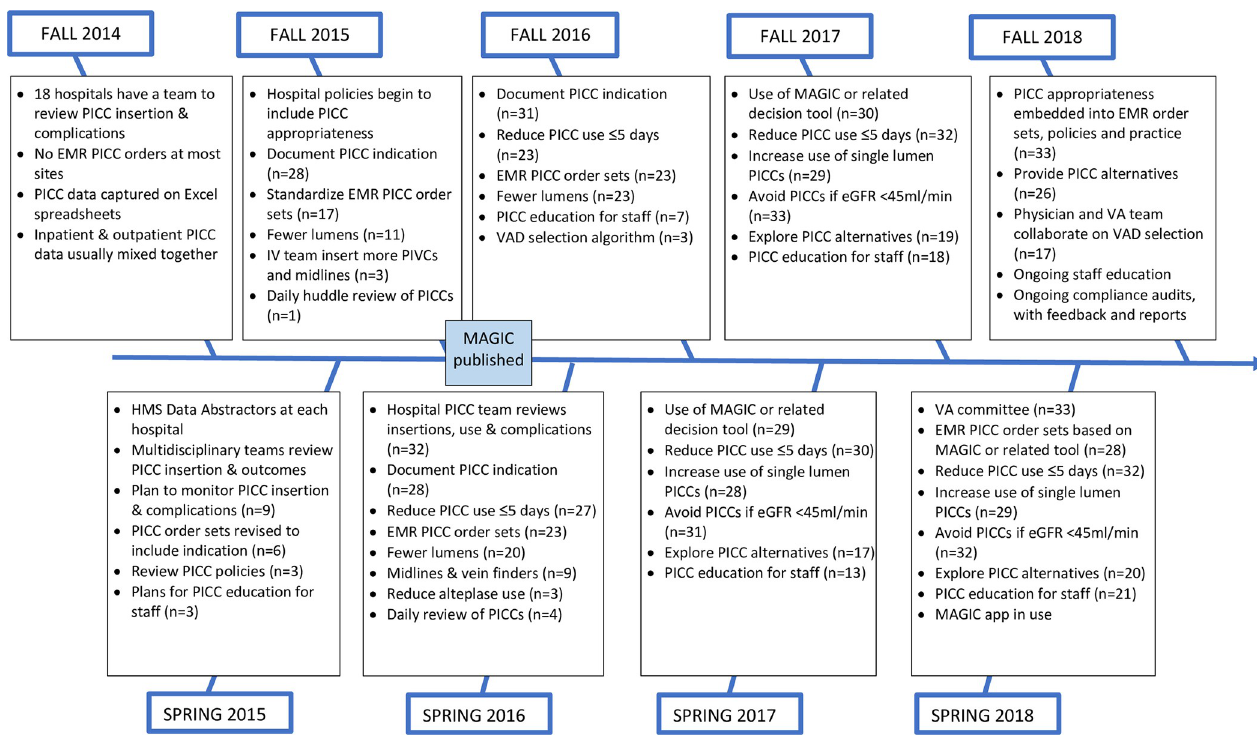
Fig 1. Implementation progress of PICC improvement strategies across 34 Michigan